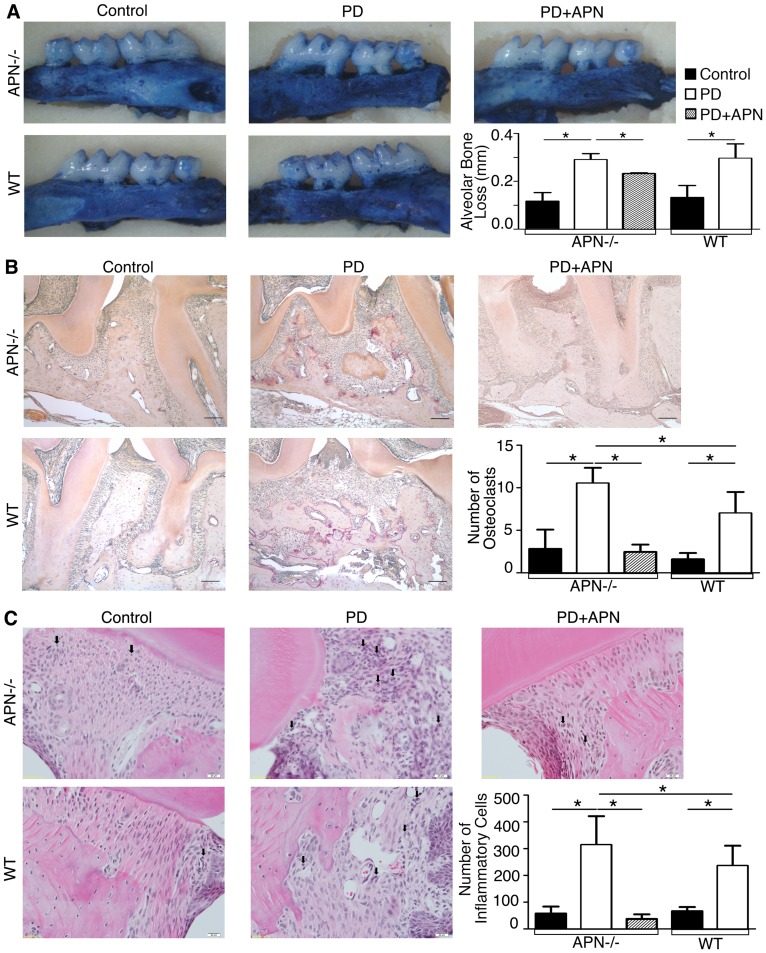
APN Inhibits Bone Resorption and Inflammation in APN−/− Mice Induced With Experimental Periodontitis.(A) Alveolar bone loss was determined in palatal bone samples stained with 1% methylene blue and photographed at 30× magnification using a dissecting microscope with the occlusal face of the molars perpendicular to the base. The distance between the cementoenamel junction and the alveolar crest was measured at 6 sites in APN−/−, APN−/−+PD, APN−/−+PD+APN, as well as WT and WT+PD mice (magnification, ×30). (B) TRAP staining determined the number of osteoclasts (magnification, ×200; scale bars, 500 µm). (C) H&E staining determined the number of inflammatory cells of palatal bone samples in APN−/−, APN−/−+PD, APN−/−+PD+APN, as well as WT and WT+PD mice (magnification, ×400; scale bars, 20 µm; black arrows = inflammatory cells). Data are shown as mean ± SD (n = 5). *P<0.05.